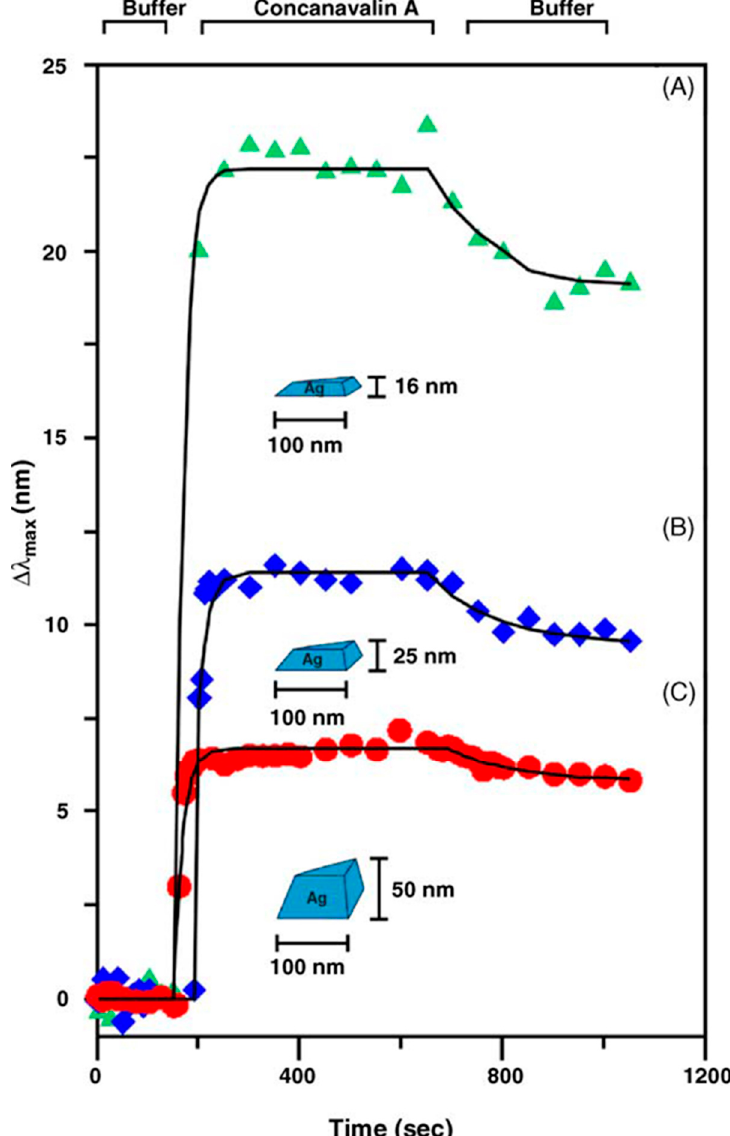
Figure 8. Real-time response (cycle) of Ag-conjugated nanosensor for a typical carbohydrate-binding protein at ( A ) 16 nm out-of plane height, ( B ) 25 nm out-of plane height, and ( C ) 50 nm out-of plane height from. Reproduced from Reference [216] with permission from Elsevier.